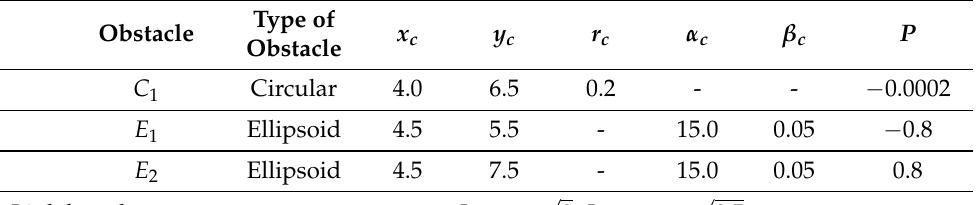
Figure 14. Case Study 2 shows a planar robotic arm with six links and a gripper, two ellipsoidal obstacles, and a circular obstacle. Table 2. Parameters of Case Study